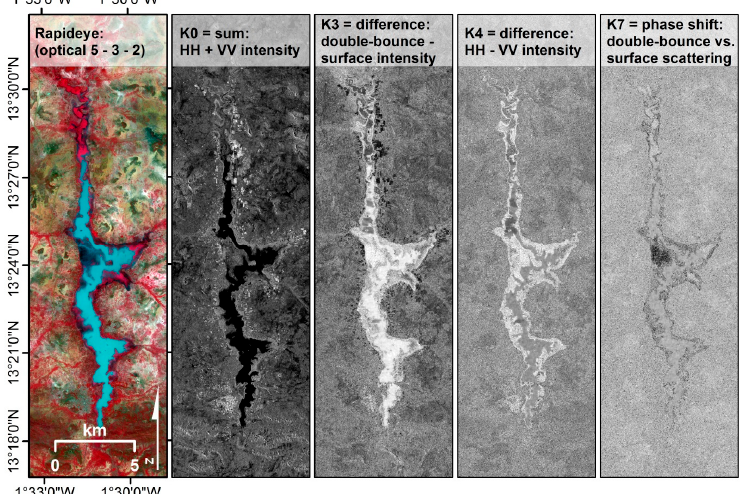
Figure 4. From left to right: A RapidEye false color composite (band 5-3-2, i.e. , NIR-red-green) reference image from 19 October 2013 (©BlackBridge 2013); the four Kennaugh elements derived from the dual-pol TSX image from 20 October 2013 (©DLR 2013): K 0 (the total intensity as sum of HH plus VV intensity); K 3 (difference double-bounce minus surface scattering); K 4 (difference HH minus VV intensity); K 7 (phase shift between double-bounce and surface scattering).